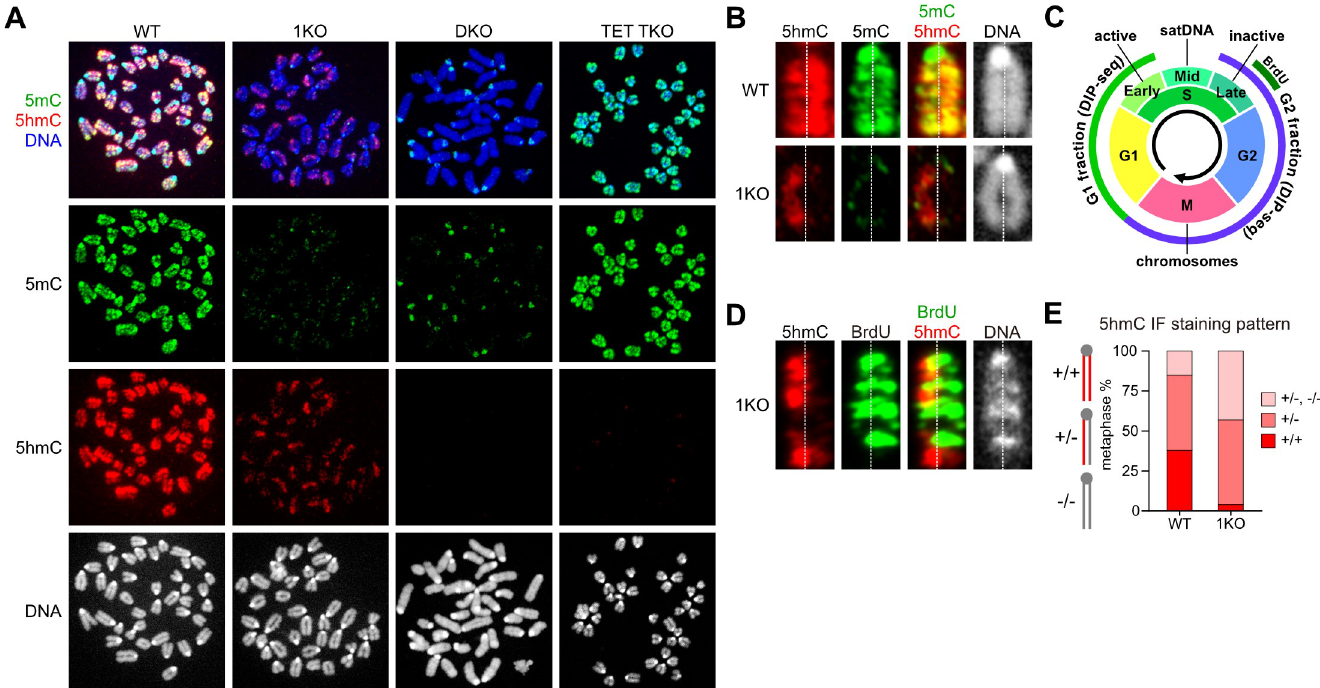
Fig 1. DNMT1 regulates de novo DNA methylation region and timing via DNMT3s. ( A ) Immunofluorescence (IF) staining patterns for 5-methylcytosine (5mC) and 5-hydroxymethylcytosine (5hmC) on metaphase chromosomes in DNMT1-deficient ESCs. WT, wild-type ESCs; 1KO, Dnmt1 -/- ESCs.; DKO, Dnmt3a -/- and Dnmt3b -/- ESCs; TET TKO, Tet1 -/- , Tet2 -/- , and Tet3 -/- ESCs. ( B ) Chromosomes show a typical IF staining pattern for 5mC and 5hmC in WT and 1KO ESCs. The dotted line indicates the space between two sister chromatids on a chromosome. ( C ) Schematic diagram showing the cell cycle information for the cell population that was used in this study. satDNA, pericentromeric heterochromatin rich in satellite repeats. ( D ) The late replicating region labeled with BrdU in S phase stains clearly with anti-BrdU antibody staining on both chromatids of each chromosome. ( E ) Mitotic cells were classified into the three categories: cells with most chromosomes that were equally positive for 5hmC on both sister chromatids (+/+); cells with the most chromosomes that were positive for 5hmC on one of the sister chromatids (+/ − ); cells that were mostly negative for 5hmC with some +/ − chromosomes (+/ − , − / − ) (n = 66 WT and n = 51 1KO metaphases).